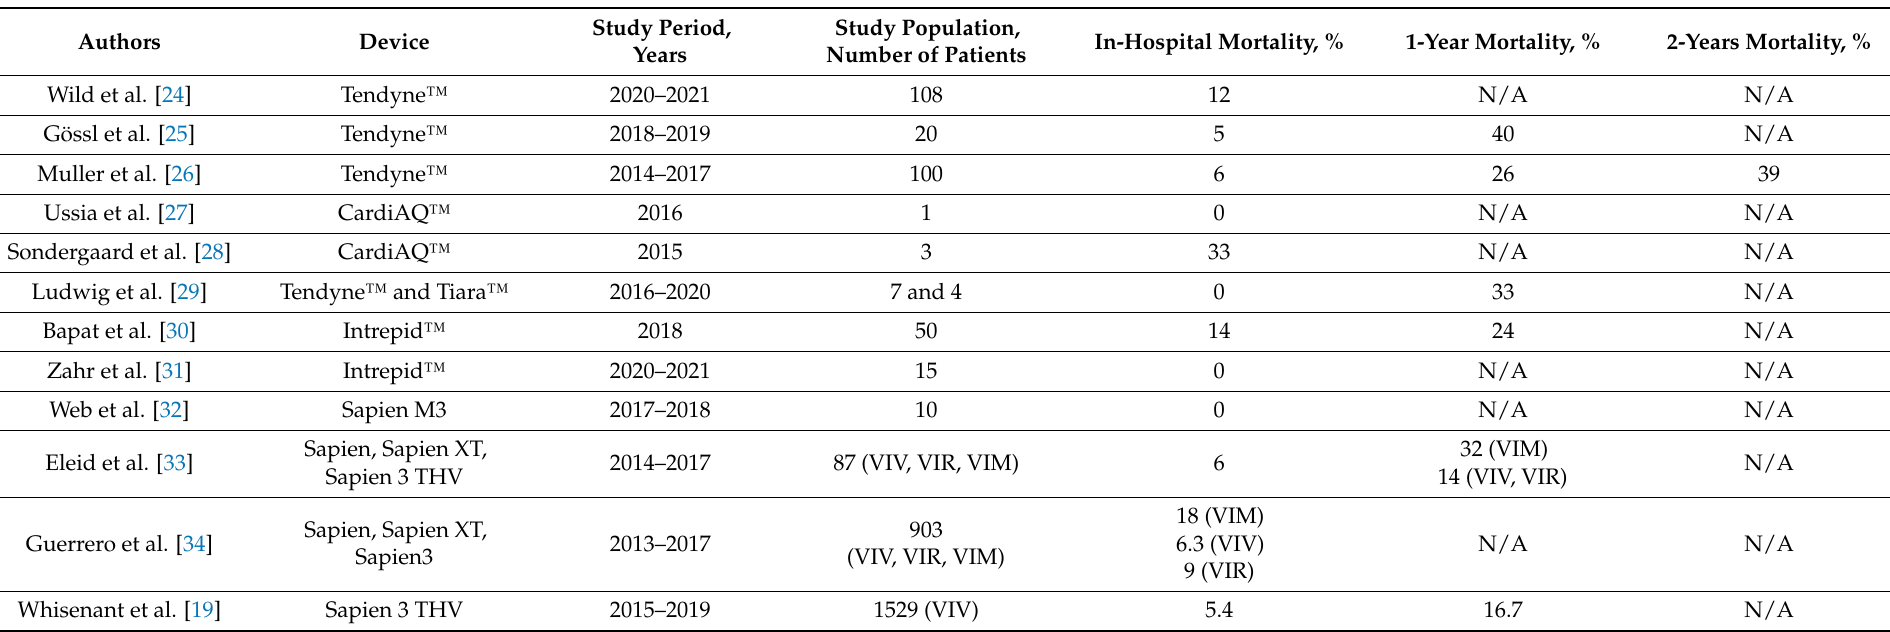
Table 2. Studies with outcomes during follow-up included in review . VIV = valve-in-valve; VIR = valve-in-ring; VIM = valve-in-mitral valve calcification; N/A = not